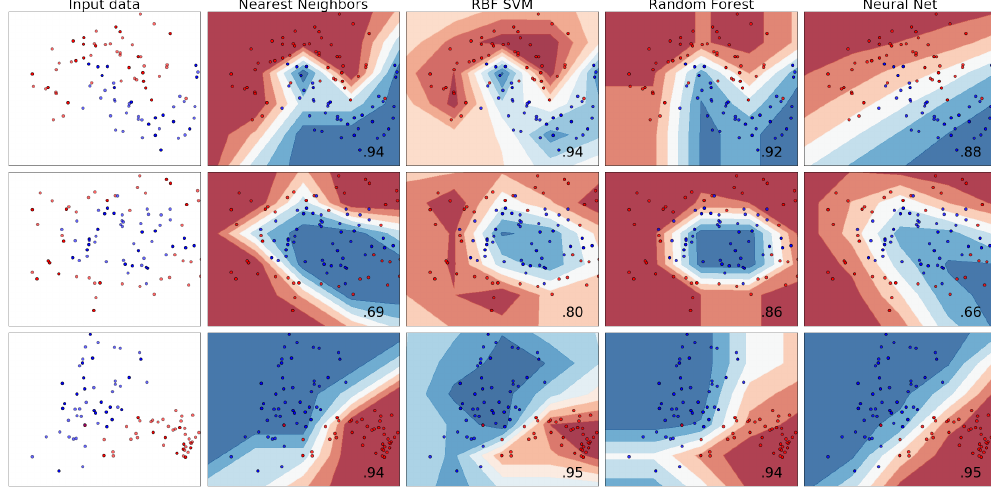
Figure 8. Comparative study of different classification models.